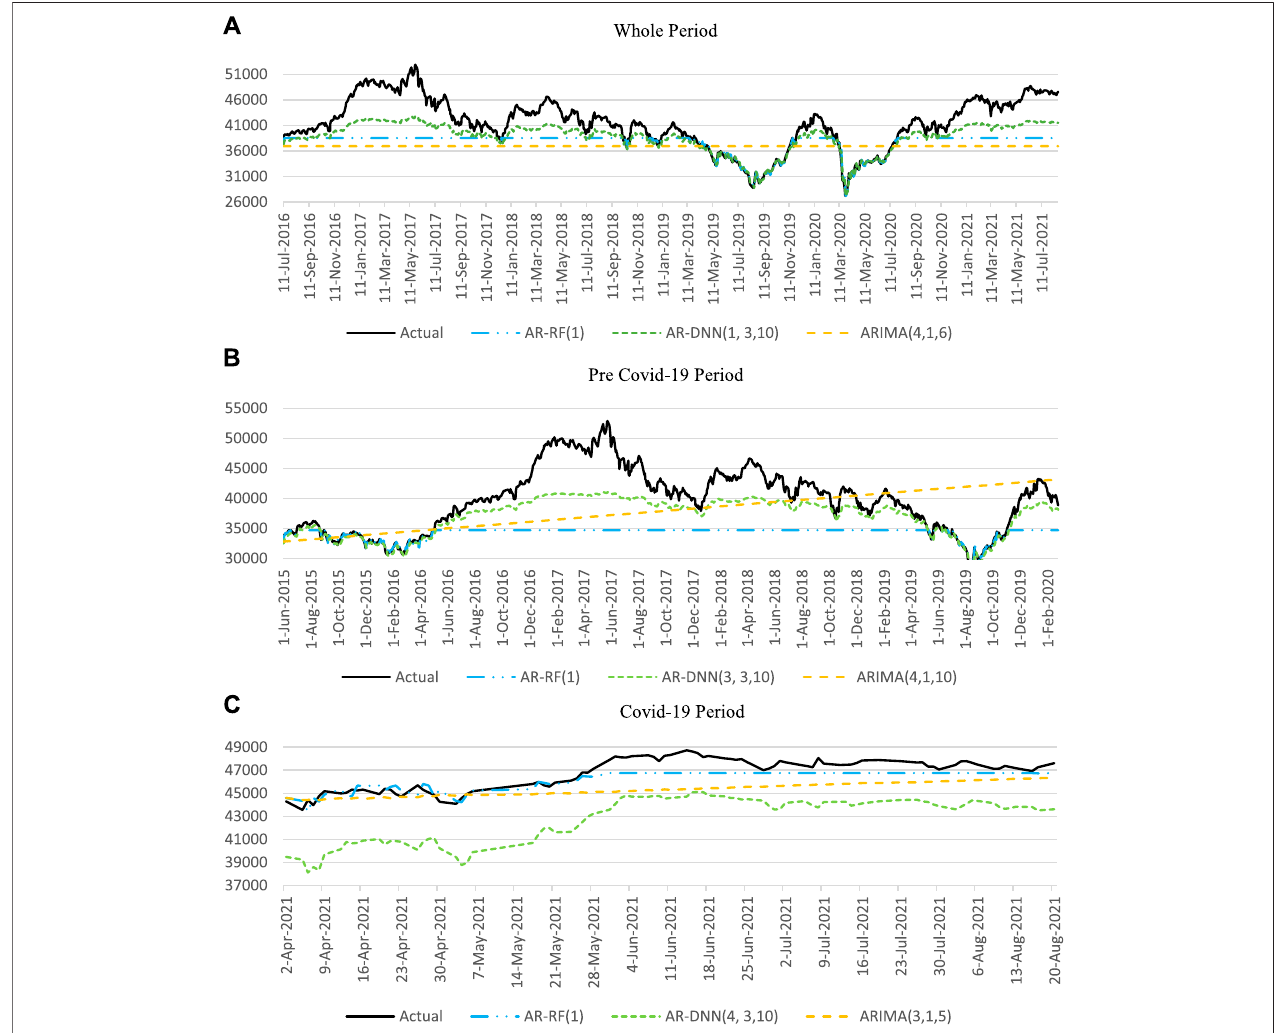
FIGURE 4 | Comparison of actual and forecasted stock index prices using test data: (A) whole period, (B) pre-Covid-19 period, and (C) Covid-19 period.